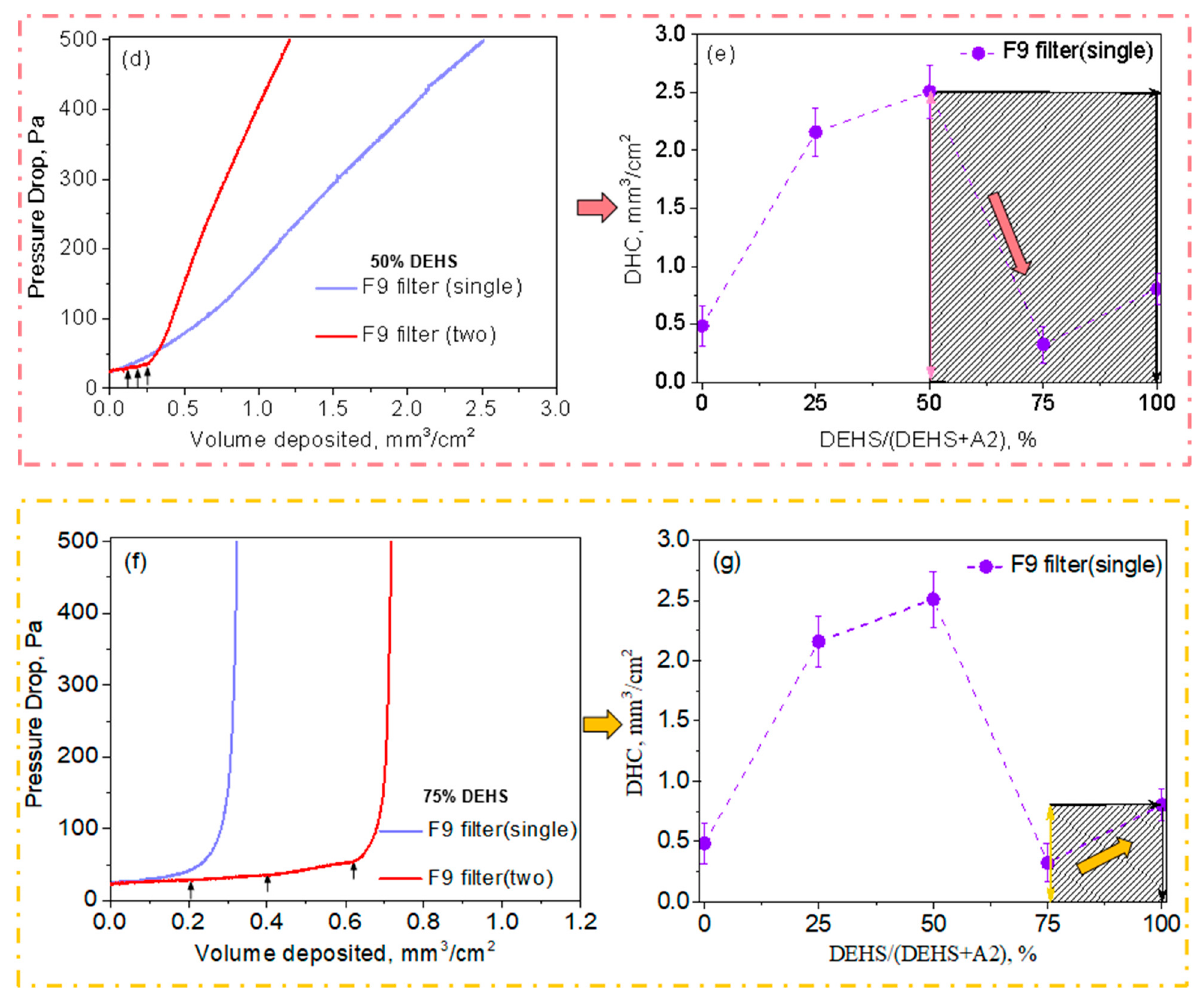
Figure 12. The loading process and the DHC of F9 filters in single-stage and two-stage when challenged with different oil-coated particles: ( a ) loading process for 100% pure solid particles, ( b ) loading process for (25/75%) oil/solid mixed particles, ( c ) DHC for (25/75%) oil/solid mixed particles, ( d ) loading process for(50/50%) oil/solid mixed particles, ( e ) DHC for(50/50%) oil/solid mixed particles, ( f ) loading process for (75/25%) oil/solid mixed particles, ( g ) DHC for (75/25%) oil/solid mixed particles.